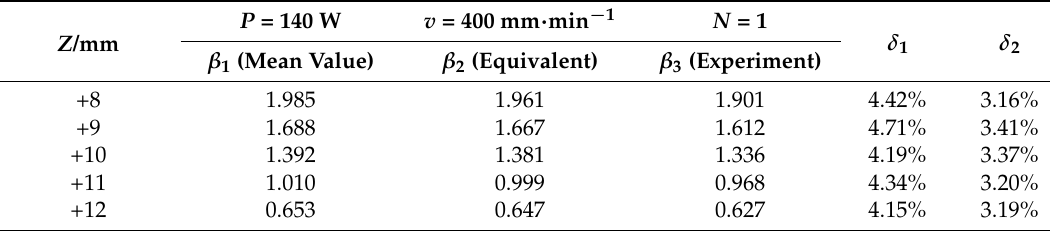
Table 6. Comparison of bending angle and error between the mean value method and the equivalent method with different defocus distance.